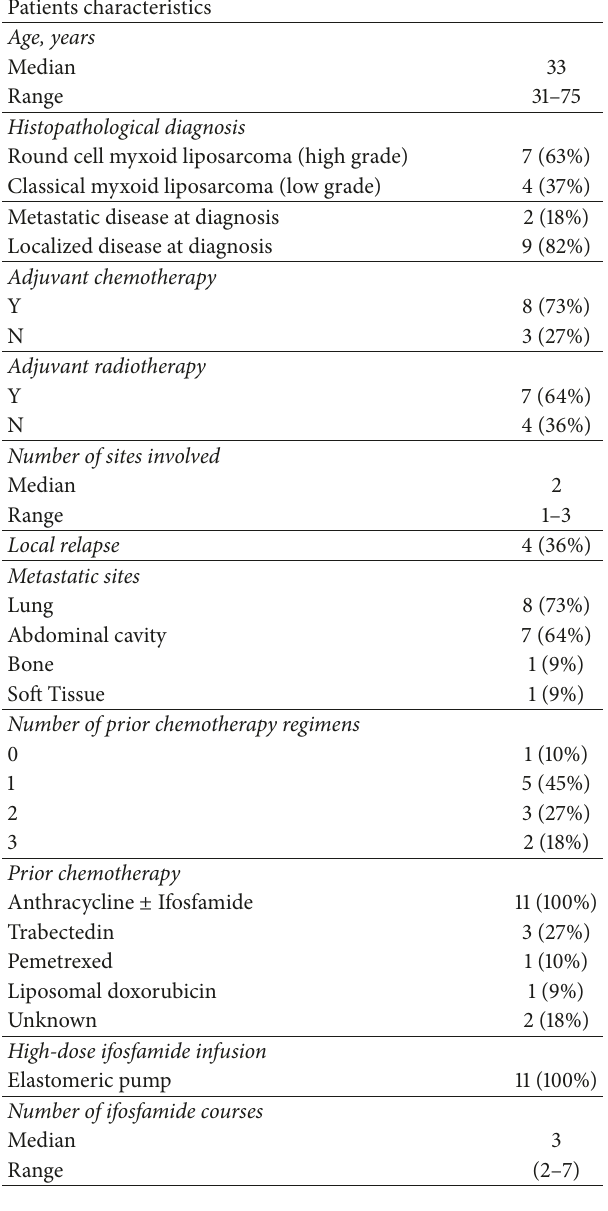
Table 1: Patients characteristics at chemotherapy when starting ifosfamide.